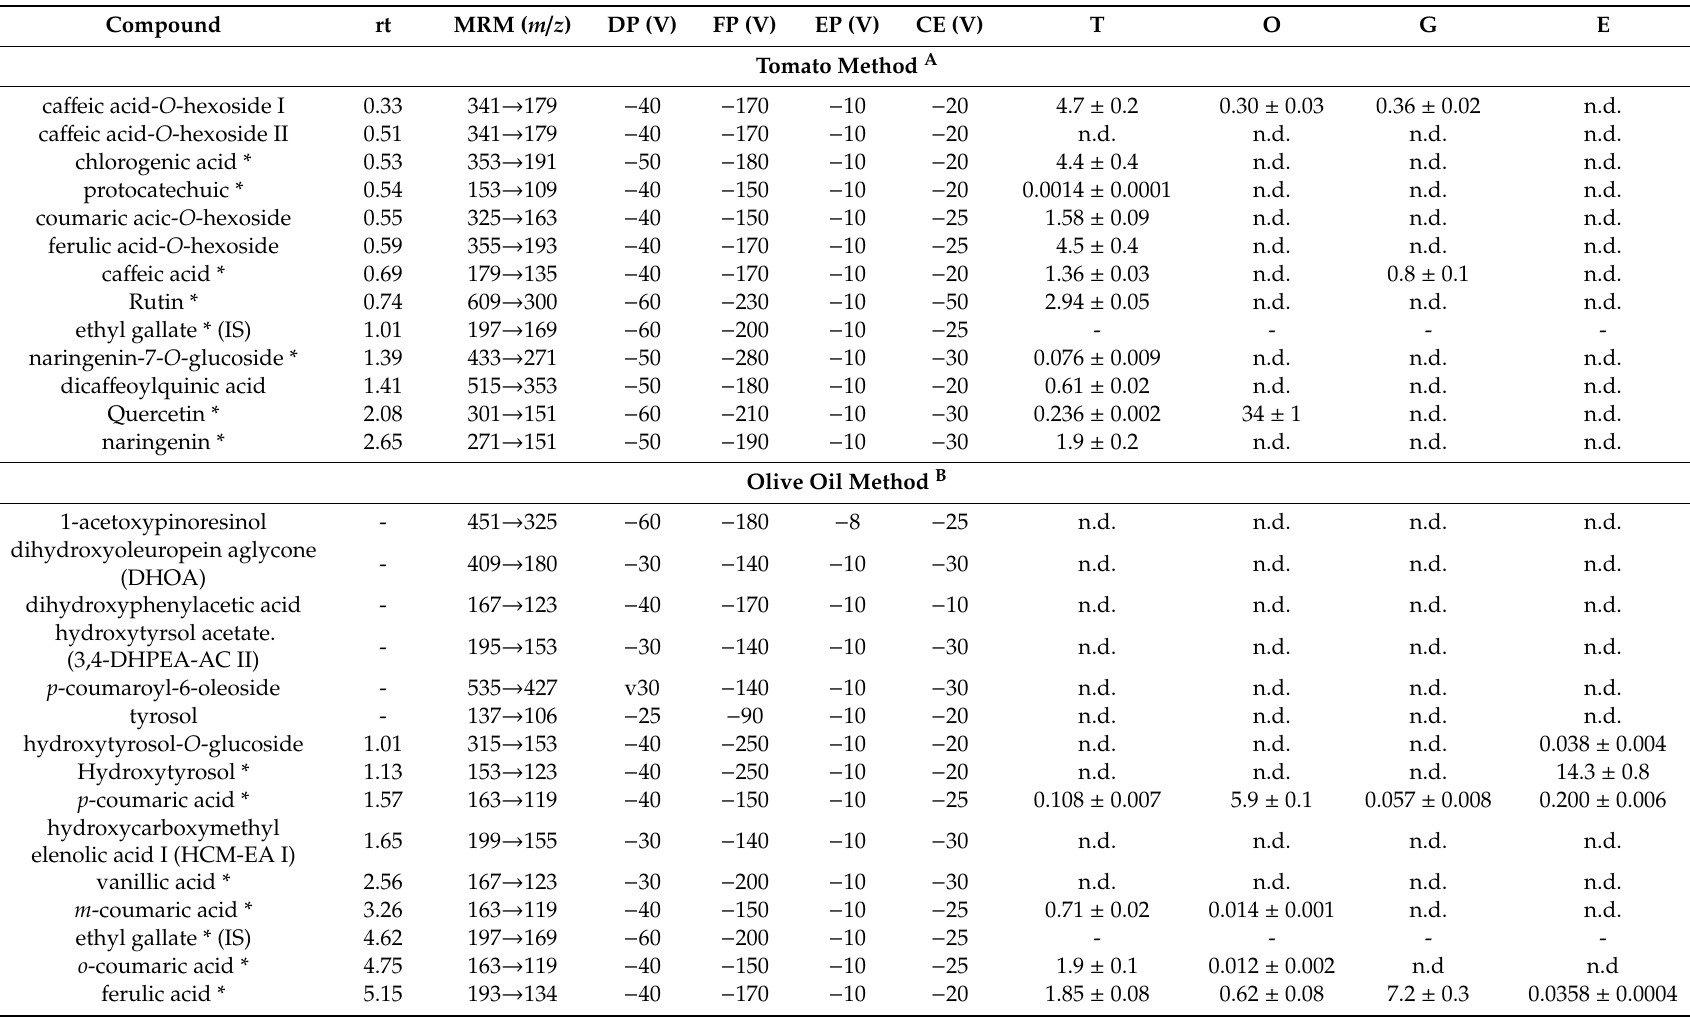
Table 1. Polyphenols monitored and quantified in the ingredients of the tomato-based sofrito sauce expressed in µ g / g of ingredient.